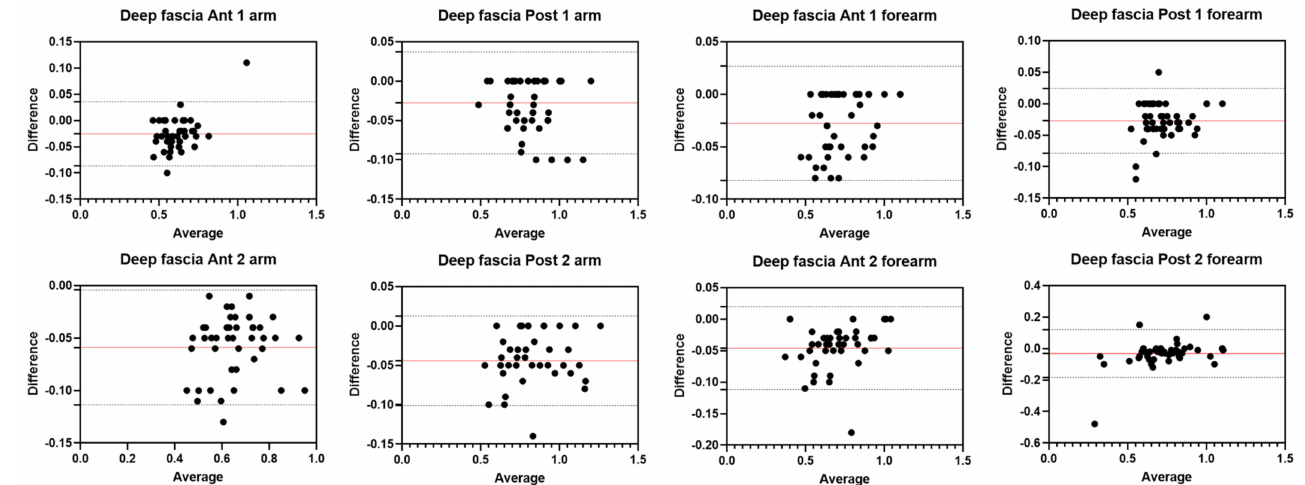
Figure 11. Bland–Altman plot comparing two raters (R1 and R2) measuring the US thicknesses of the deep fascia of the arm and forearm for the different levels. Red line = bias or mean difference; dashed lines: 95% limits of agreement (LoAs).